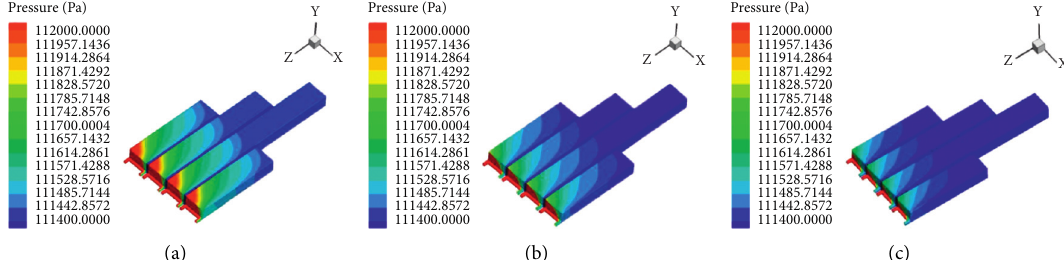
Figure 10: Simulation results at different air inlet pressures. (a) At air inlet pressure of 112,400 Pa. (b) At air inlet pressure of 112,000 Pa. (c) At air inlet pressure of 111,800 Pa.